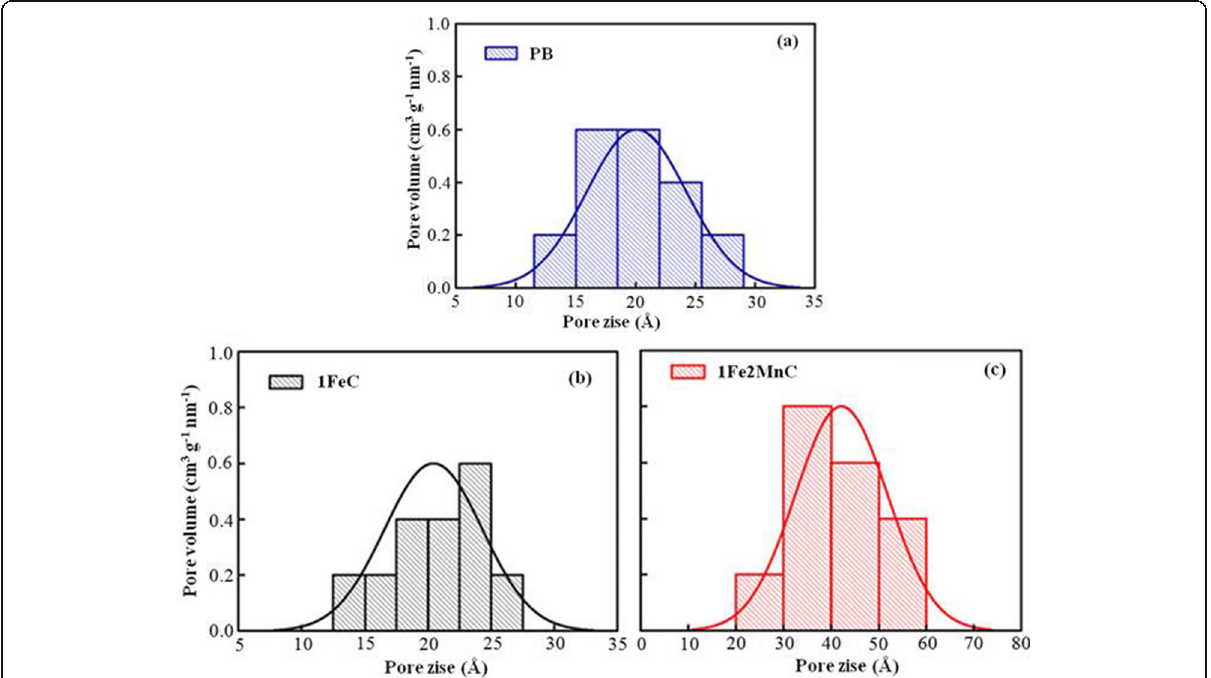
Fig. 4 The pore size distribution of a PB, b 1FeC and c 1Fe2MnC